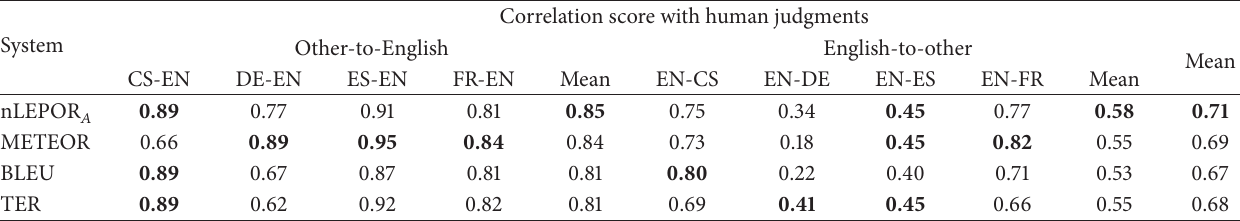
Table 6: The performances on WMT12 testing corpora using Spearman correlation.